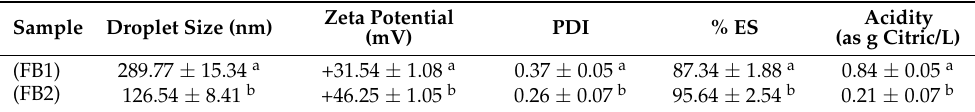
Table 1. The particle size, zeta potential, and poly dispersing index of the microemulsion prepared using garlic